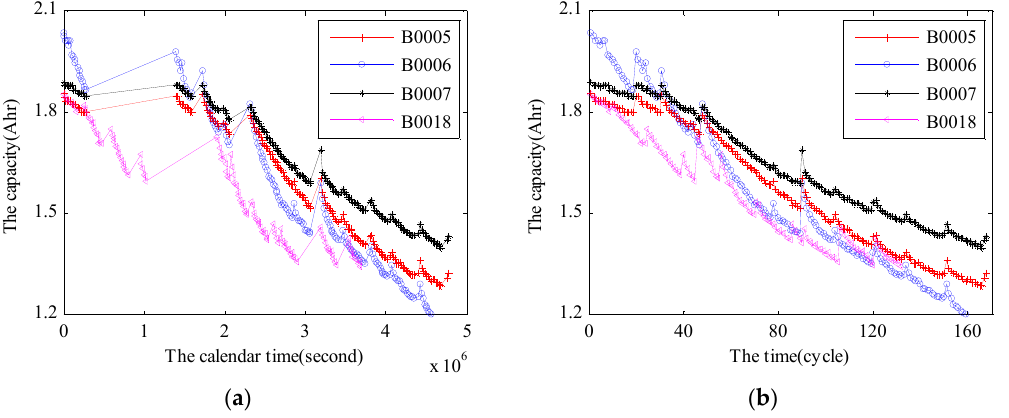
Figure 1. The experimental degradation data: ( a ) With calendar time; and ( b ) with cycle time.